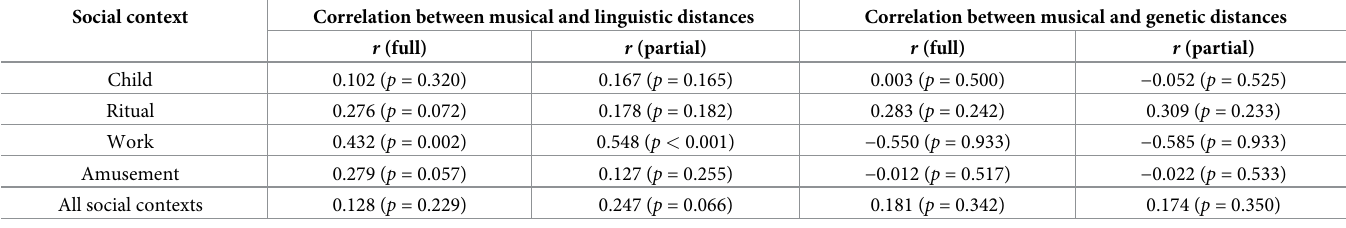
Table 4. Full and partial correlation coefficients between musical and linguistic distances among ten islands (Amami-Oshima, Okinawa, Miyako, Ikema, Irabu, Tar- ama, Ishigaki, Taketomi, Hateruma, and Yonaguni islands) and between musical and genetic distances among five islands (Kikai, Amami-Oshima, Okinawa, Miyako, and Ishigaki islands) in the Ryukyu Archipelago. Correlation between musical and linguistic distances Correlation between musical and genetic distances